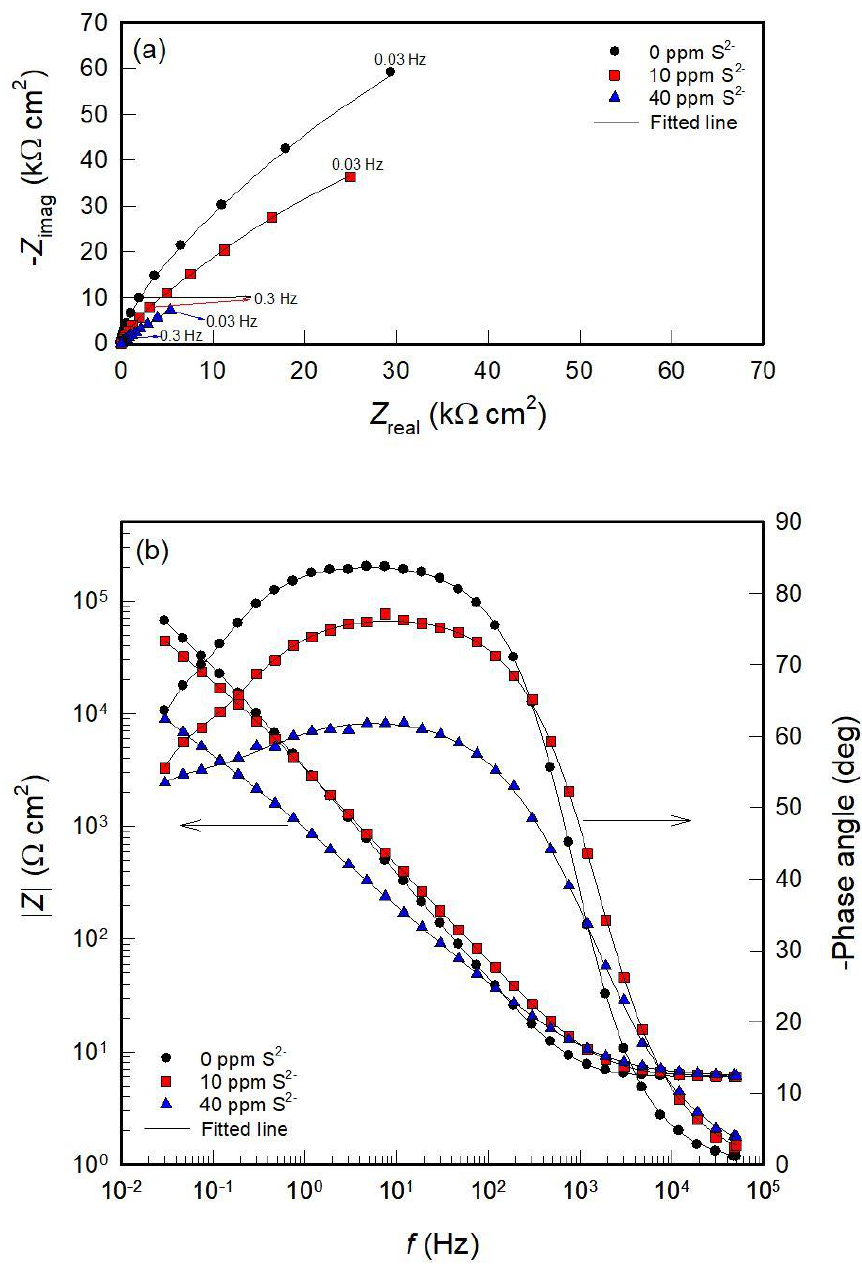
Figure 3. ( a ) Nyquist and ( b ) Bode diagrams for AISI 316L in seawater in the presence of S 2− ions at 298 K.